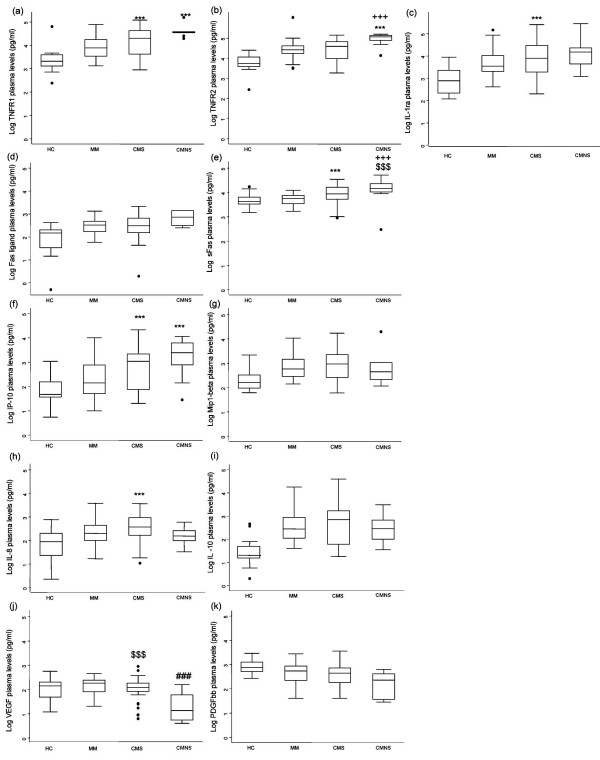
Biomarkers with significant differences between disease severity groups as determined by multivariate analyses. HC – healthy controls, MM – mild malaria, CMS – cerebral malaria survivors, CMNS – cerebral malaria non-survivors. Box plots represent medians and 25th and 75th percentiles. Bars mark the 10th and 90th percentiles, and outliers are plotted as points. MM versus CMS and CMNS: *** p < 0.05, $$$ p < 0.0045 bonferroni adjustment (alpha = 0.05/11), CMS versus CMNS: +++ p < 0.05, ### p < 0.0045 bonferroni adjustment (alpha = 0.05/11).